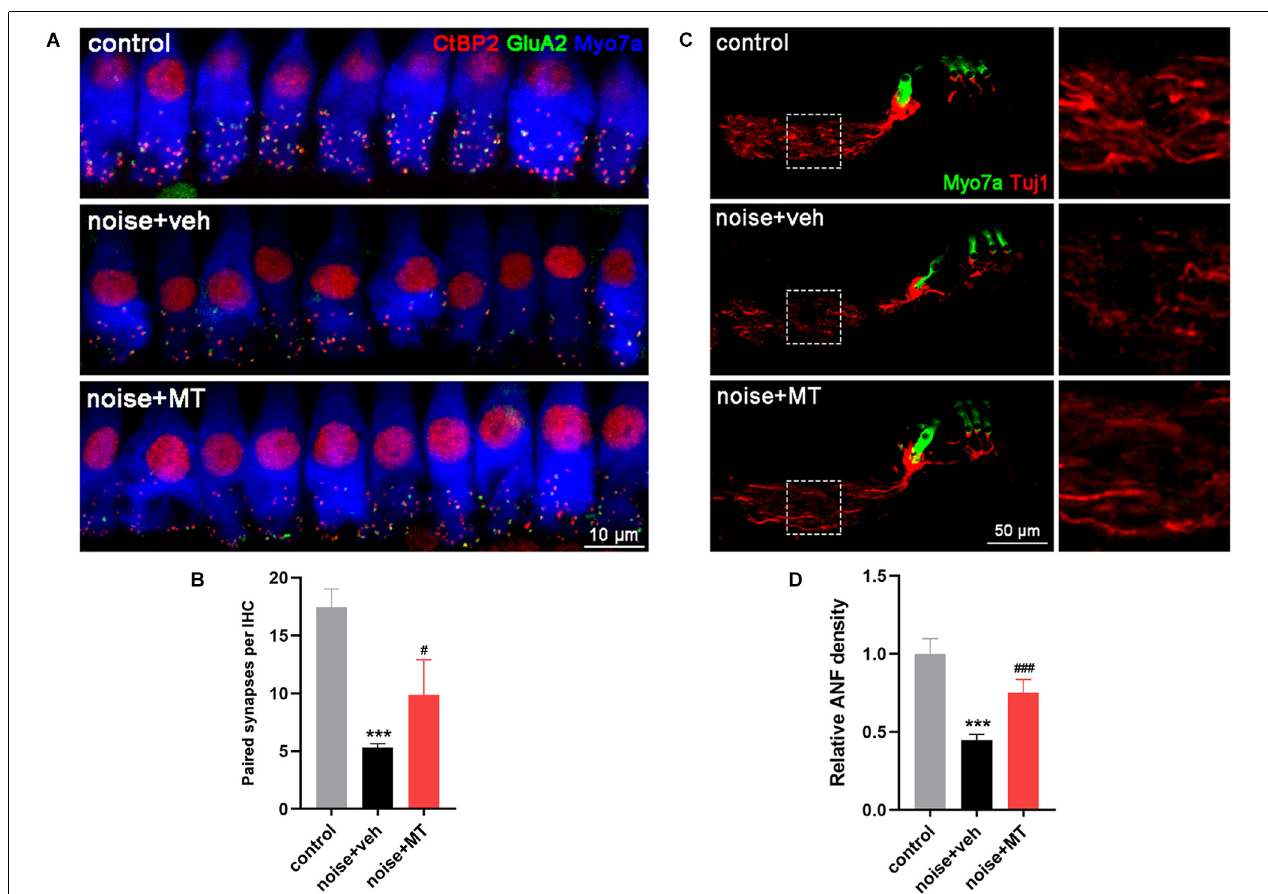
FIGURE 4 | MT treatment reduced IHC ribbon synapse loss and ANF degeneration induced by acoustic trauma. (A) Representative images of the IHC ribbon synapse at approximately 16–20 kHz region of the cochlea 14d after the noise exposure. Cochlear surface preparations were immunolabelled with CtBP2 (red), GluA2 (green) and Myosin VIIa (blue). (B) Quantification analysis of paired synapse per IHC, indicated by the juxtaposition of CtBP2 and GluA2. (C) Representative images of ANF and HCs in middle turn area of the midmodiolar sections 14d after the noise exposure. Cochlear sections were immunolabelled with Tuj1 (red) and Myosin VIIa (green). (D) Quantification analysis of ANF density 14d after the noise exposure. Data are presented as means ± SD, n = 4 for each group, *** p < 0.001 vs. control group, # p < 0.05 vs. vehicle-treated group, ### p < 0.001 vs. vehicle-treated group. IHC, inner hair cell; ANF, auditory nerve fiber.